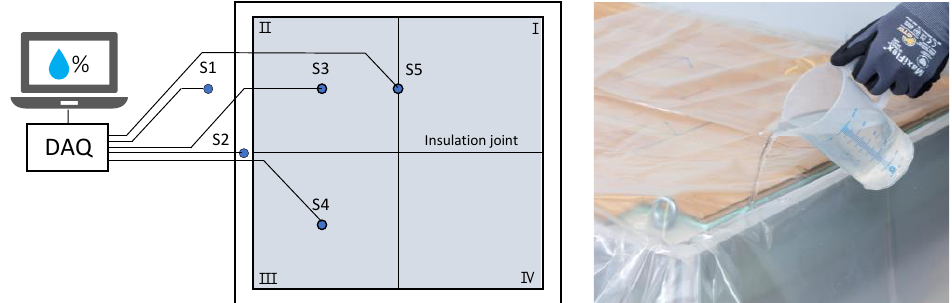
Figure 4. Evaluation of the resulting insulation damage through the use of embedded humidity